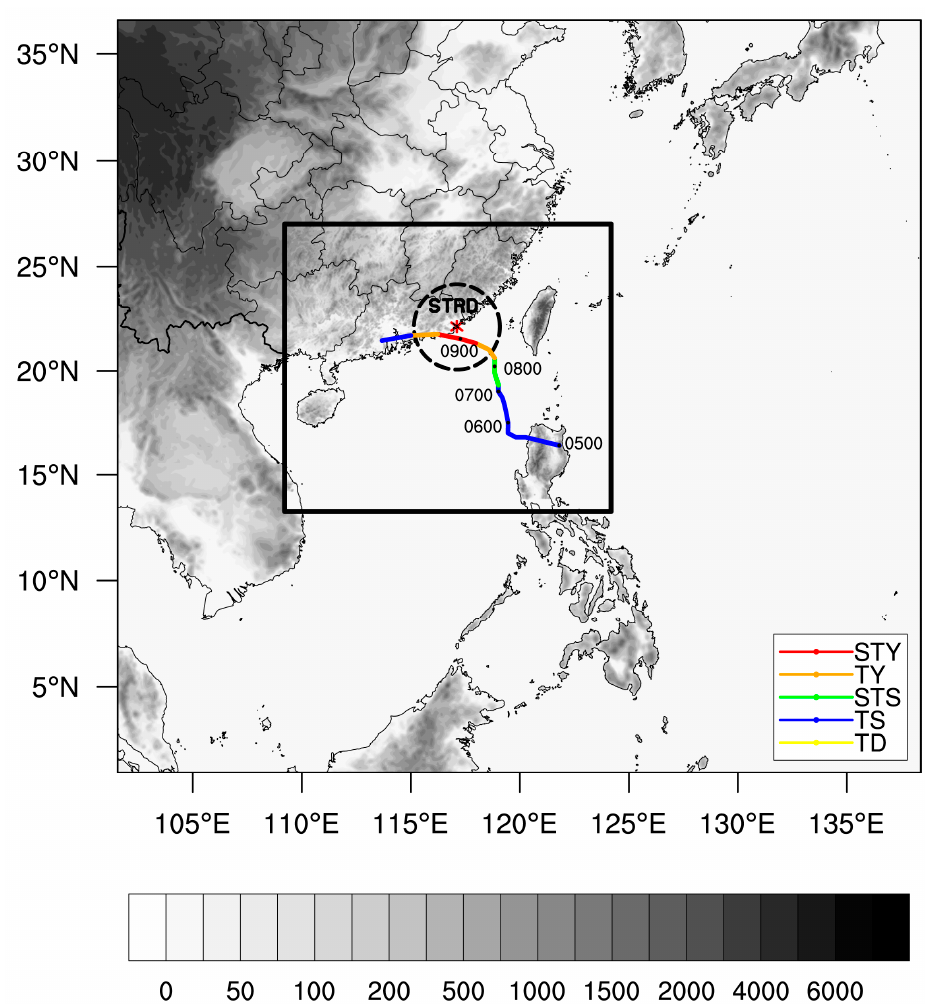
Figure 2. The weather research and forecasting (WRF) model domains with the China Meteorological Administration’s (CMA) best tracking of Typhoon Linfa from 0000 UTC on July 5 to 1800 UTC on 9 July 2015. The location of the STRD is indicated by asterisks. The maximum detection range of the STRD is circled at 230 km. Tropical cyclones are distinguished by their color: tropical depression (TD), tropical storm (TS), severe tropical storm (STS), typhoon (TY), and severe typhoon (STY). The shading indicates the terrain height (unit: m).